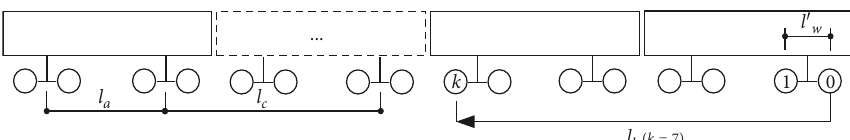
Figure 2: Spacing of axles in a train.